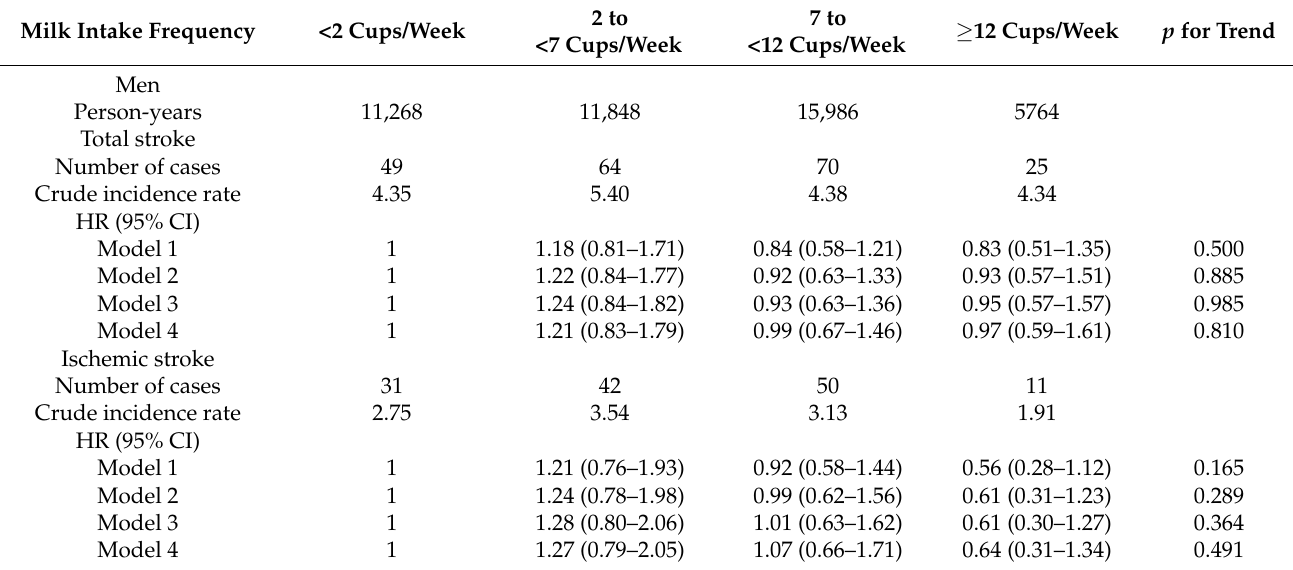
Table 3. Multivariate adjusted hazard ratios for total stroke, ischemic stroke, and hamorrhagic stroke, according to milk intake frequency categories by sex, 2002–2014, Iwate-KENCO